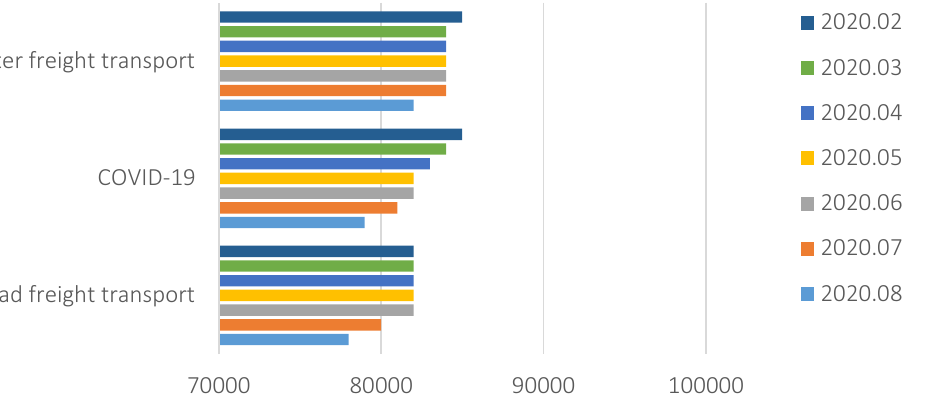
Figure 2. COVID-19 and China’s freight traffic